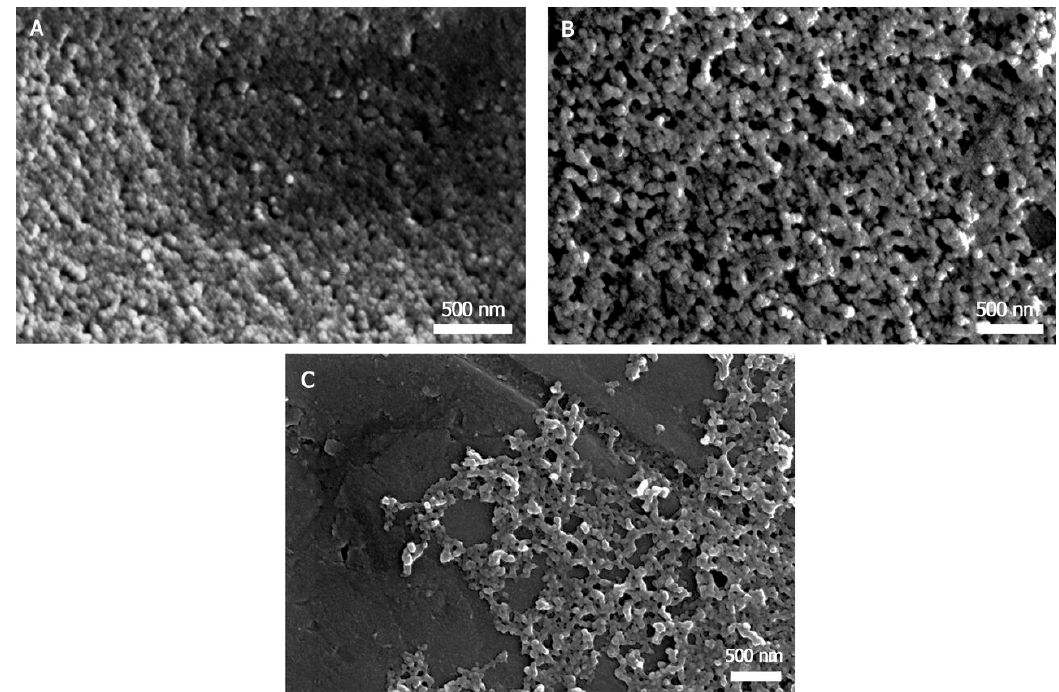
Figure 3. Field Emission Scanning Electron Microscopy pictures of: ( A ) silk fibroin nanoparticles; ( B ) curcumin-loaded silk fibroin nanoparticles synthesized by physical adsorption; and ( C ) curcumin-loaded silk fibroin nanoparticles synthesized by coprecipitation.